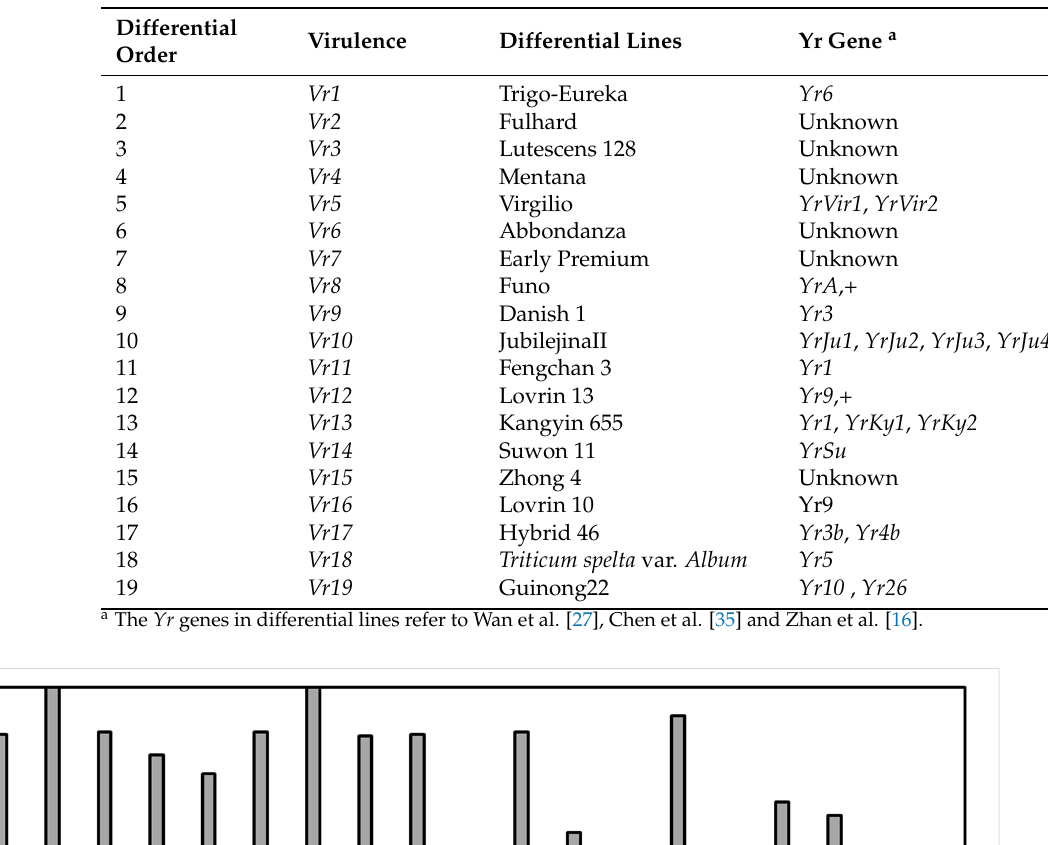
Table 1. Chinese differential lines used to identify races of Puccinia striiformis f. sp. tritici isolates collected from Yili, Xinjiang, China, in 2021.